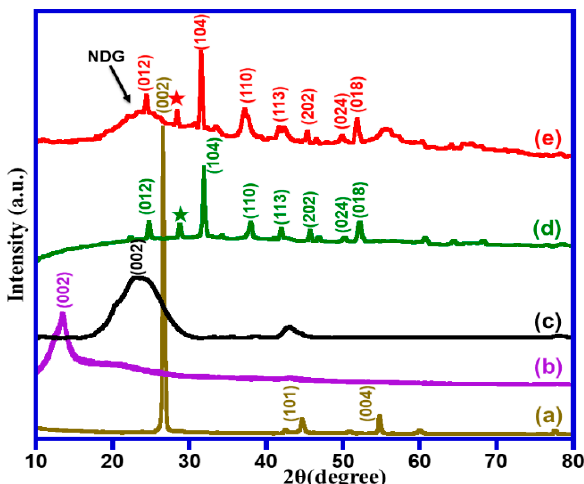
Figure 1. XRD diffractograms of ( a ) graphite, ( b ) GRO, ( c ) NDG, ( d ) MnCO 3 –(1%)ZrO 2 and ( e ) (1%) NDG/MnCO 3 –(1%)ZrO 2 samples.